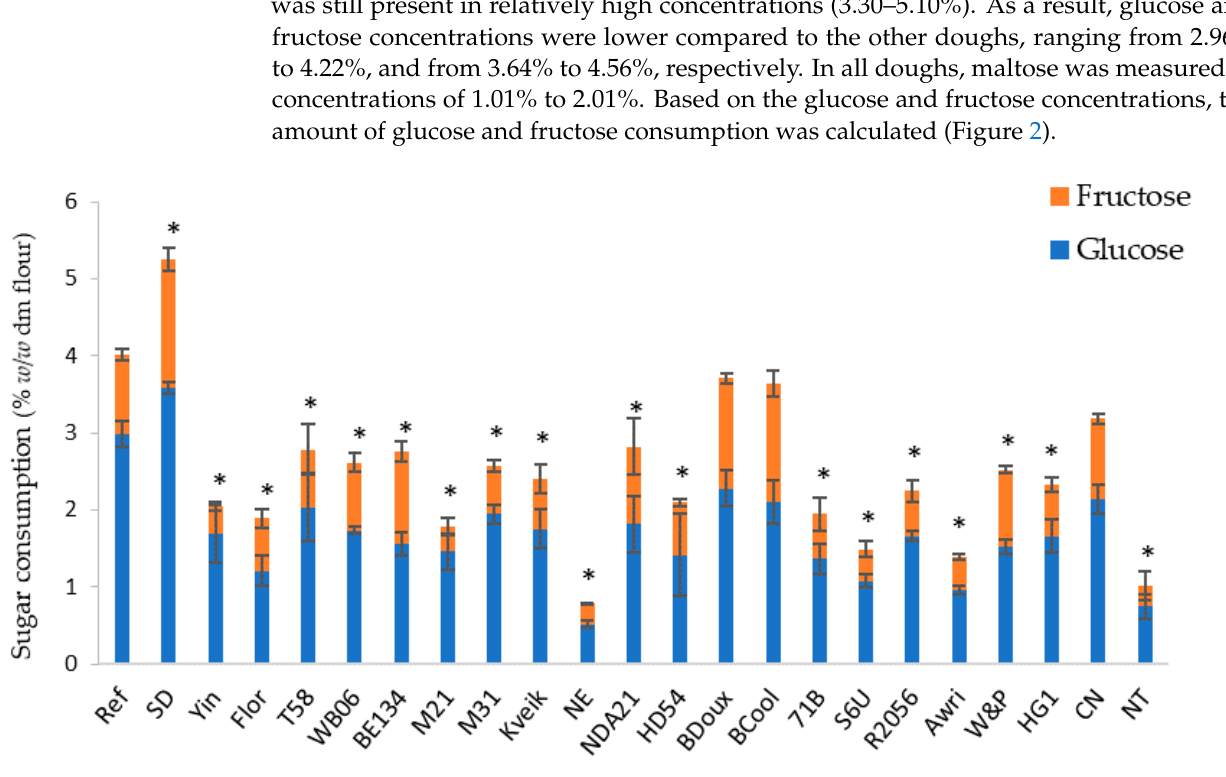
Table 2. CO 2 production and ethanol, glycerol, succinic acid, and acetic acid concentrations in doughs with 23 different yeast strains after a fermentation step of 120 min at 30 °C. Concentrations are expressed on flour dry matter base (% w / w dm flour). Standard deviations of triplicate meas- urements are presented for each product. Sample